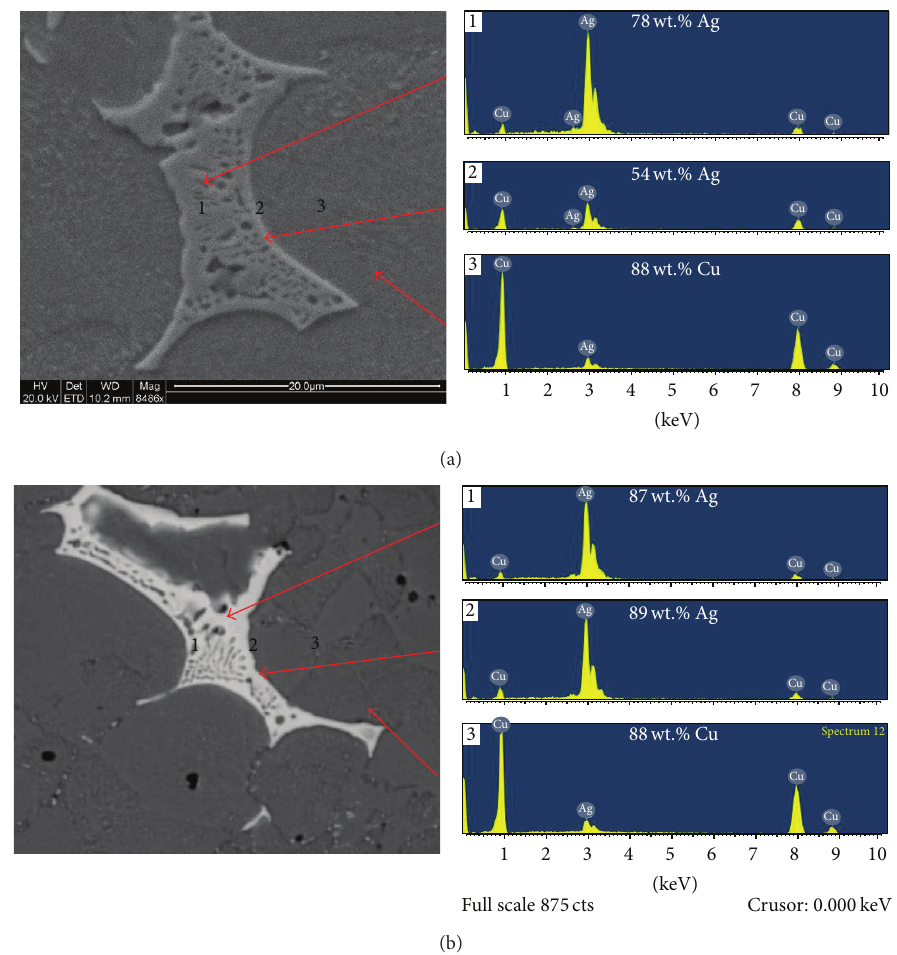
Figure 5: SEM image and EDX analysis of Cu + 10 wt.% eutectic held at 825 ∘ C for sintering time of (a) 5 minutes and (b) 20